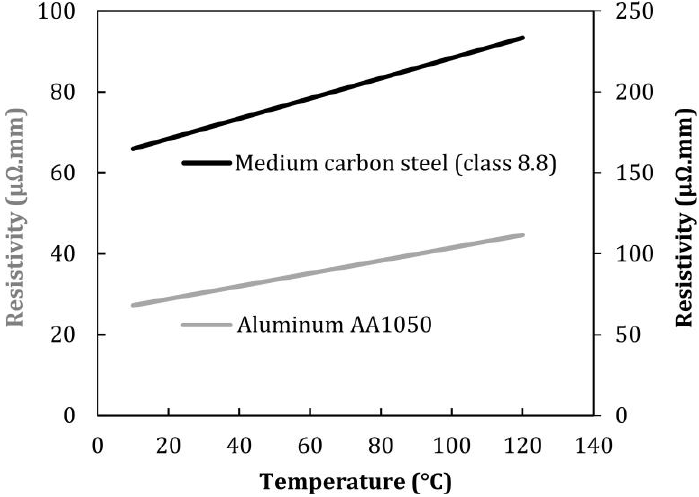
Figure 4. Electric resistivity of aluminum AA1050 (left vertical axis) and medium carbon steel (class 8.8) (right vertical axis) as a function of temperature.